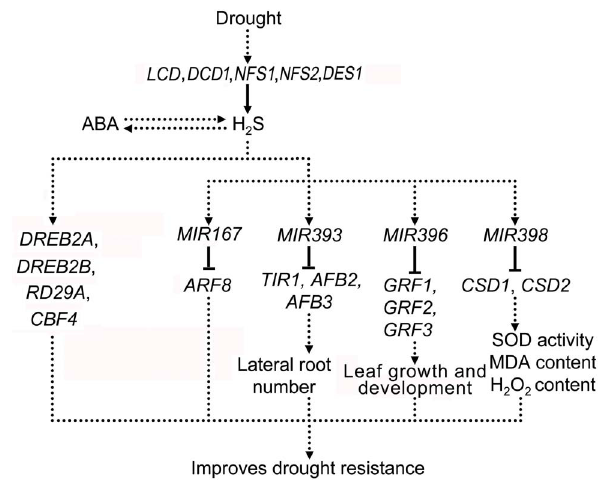
Figure S2 CAT activity and POD activity in WT and lcd plants treated with PEG8000. ( A ) CAT activity was measured